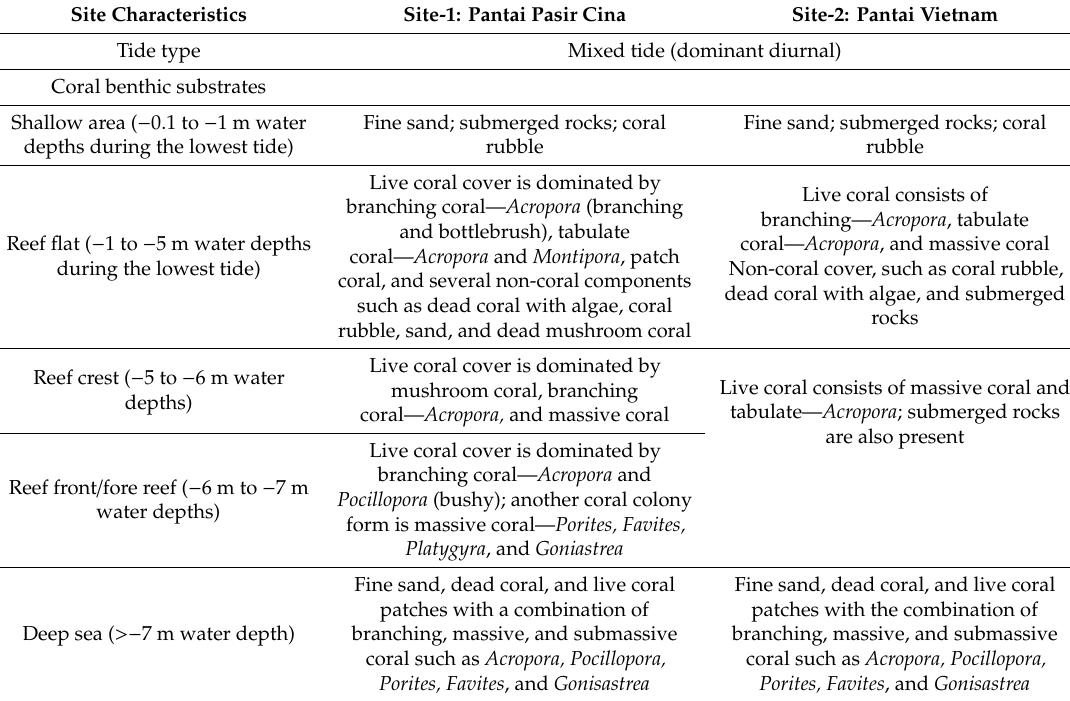
Table 1. Coral benthic habitat characteristics of study sites.